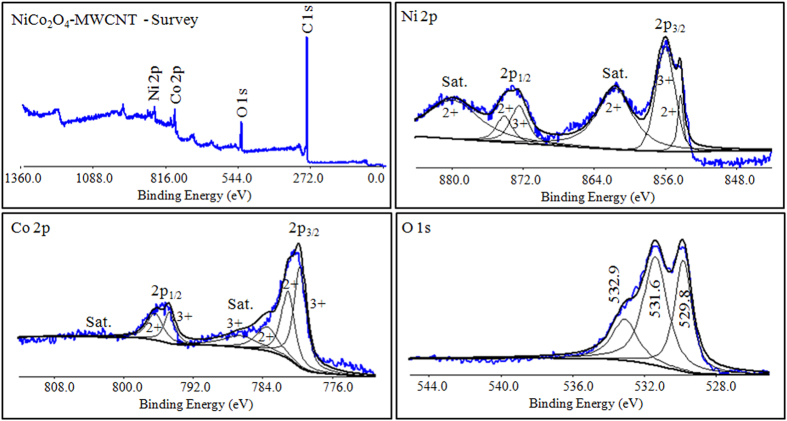
XPS spectrum of NiCo2O4/MWCNT: Survey spectrum (top-left), Ni 2p (top-right), Co 2p (bottom-left), O 1 s (bottom-right).